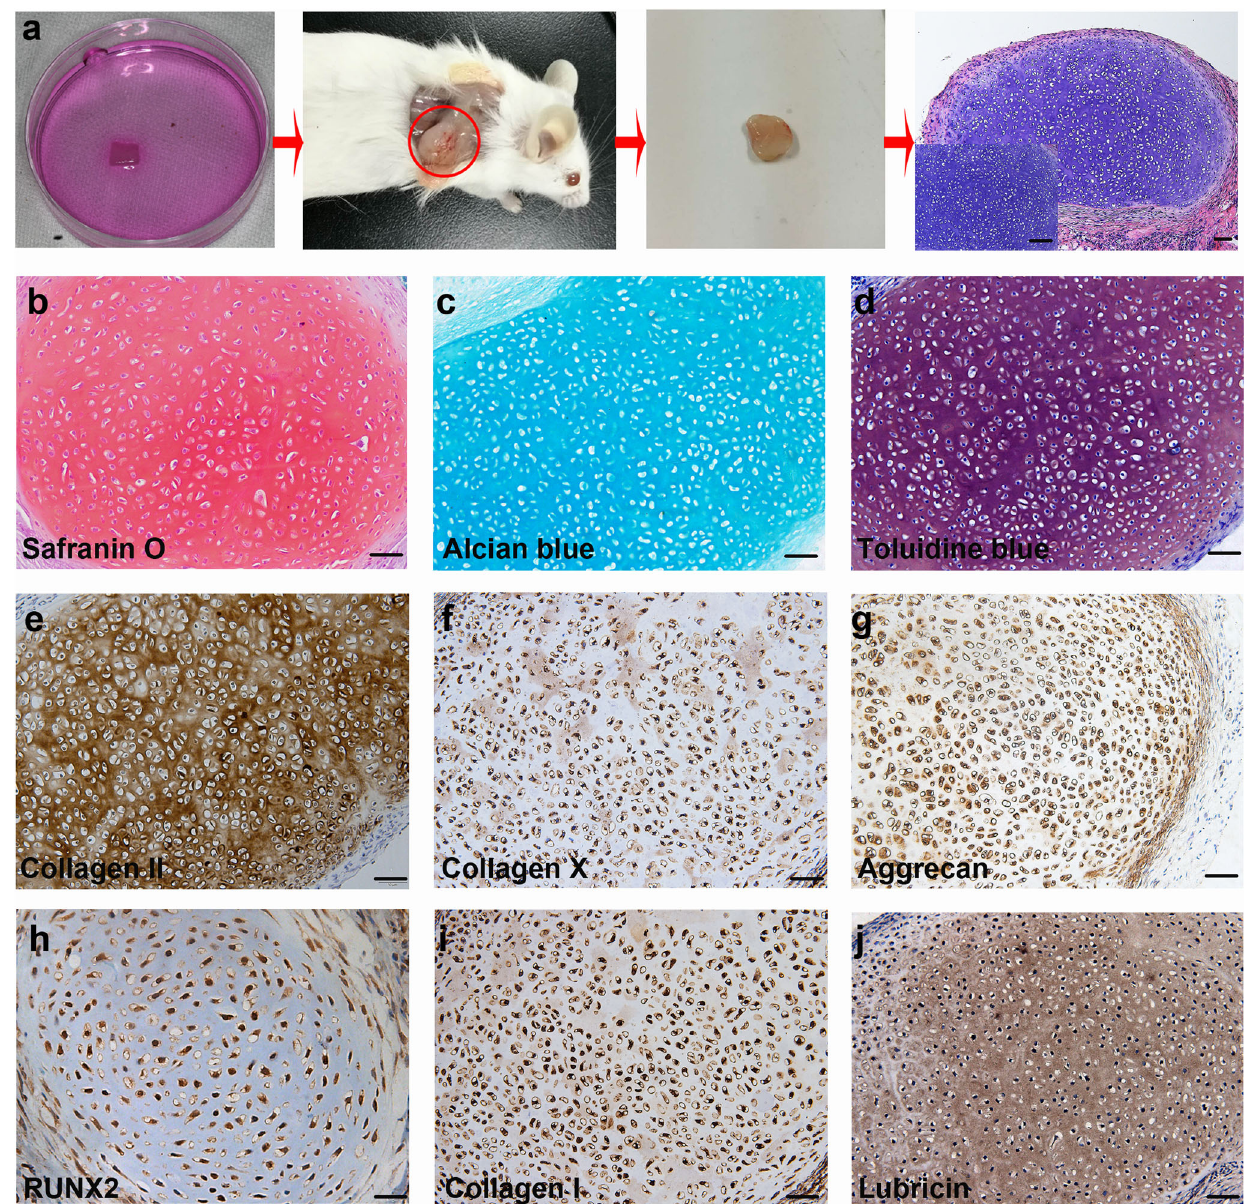
Fig. 4 ECCs can generate cartilage in vivo without teratoma formation. a Schematic representation showing ECCs seeded in a collagen sponge in vitro for 4 weeks and surgically transplanted subcutaneously into the dorsum of NOD-SCID mice. The implants were harvested after 4 weeks and histologically con fi rmed to be cartilage. (Inset) Enlargement of HE staining. Scale bars, 200 µm. (Inset) Scale bars, 50 µm. b – d Harvested cartilage was positive for safranin O, alcian blue and toluidine blue staining. Scale bars, 100 µm. e – j Immunohistochemical staining showing that differentiated chondrocytes express common chondrocytic markers, including collagen II, collagen X, aggrecan, RUNX2, collagen I, and the articular cartilage marker lubricin. Scale bars, 100